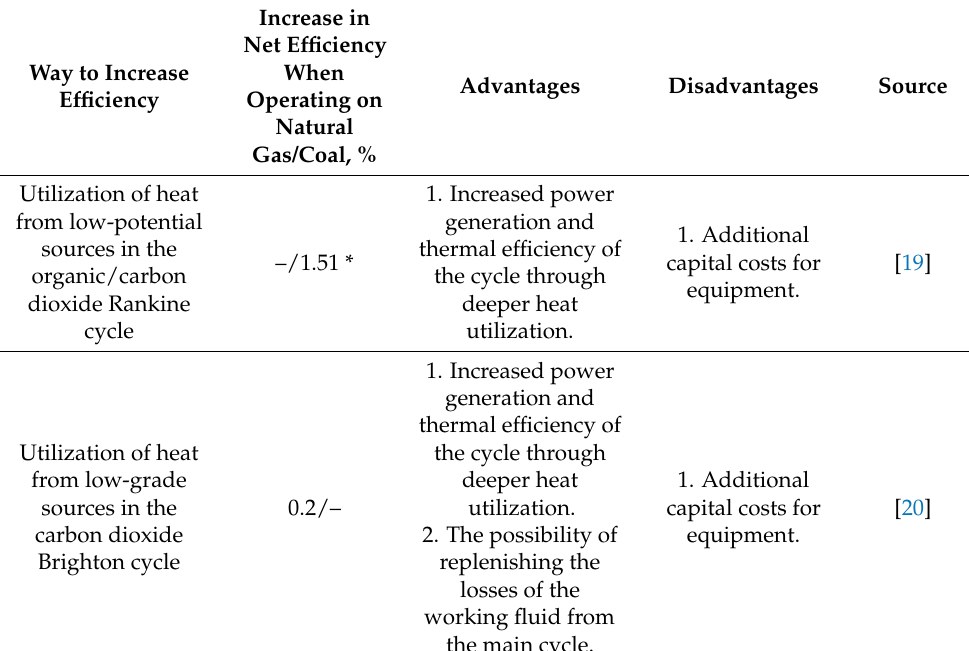
Table 1. Comparison of different methods to improve the efficiency of the Allam